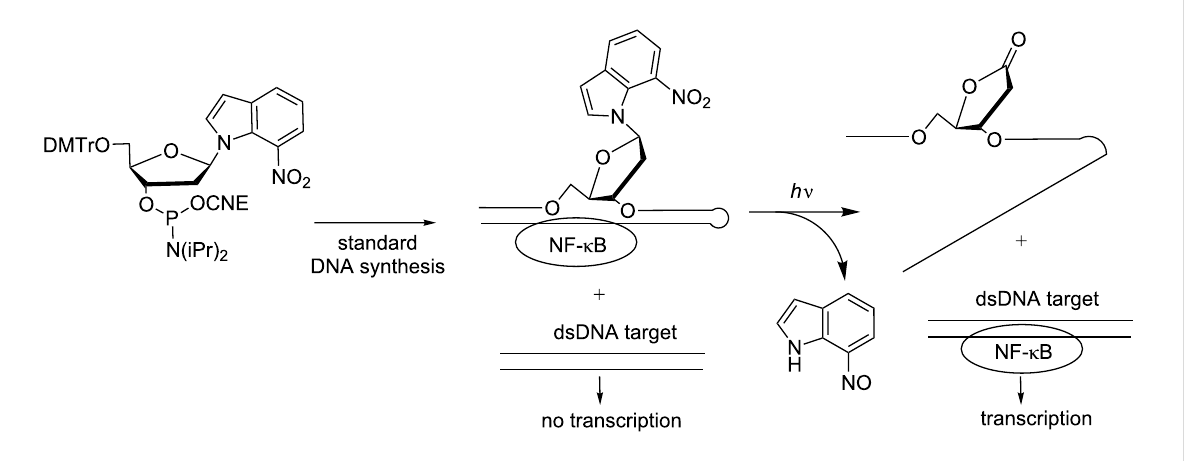
Figure 5: Caged-2’-adenosines used by MacMillan et al [93,94] (X = O) and Piccirilli et al [95] (X = S) to study RNA mechanisms.